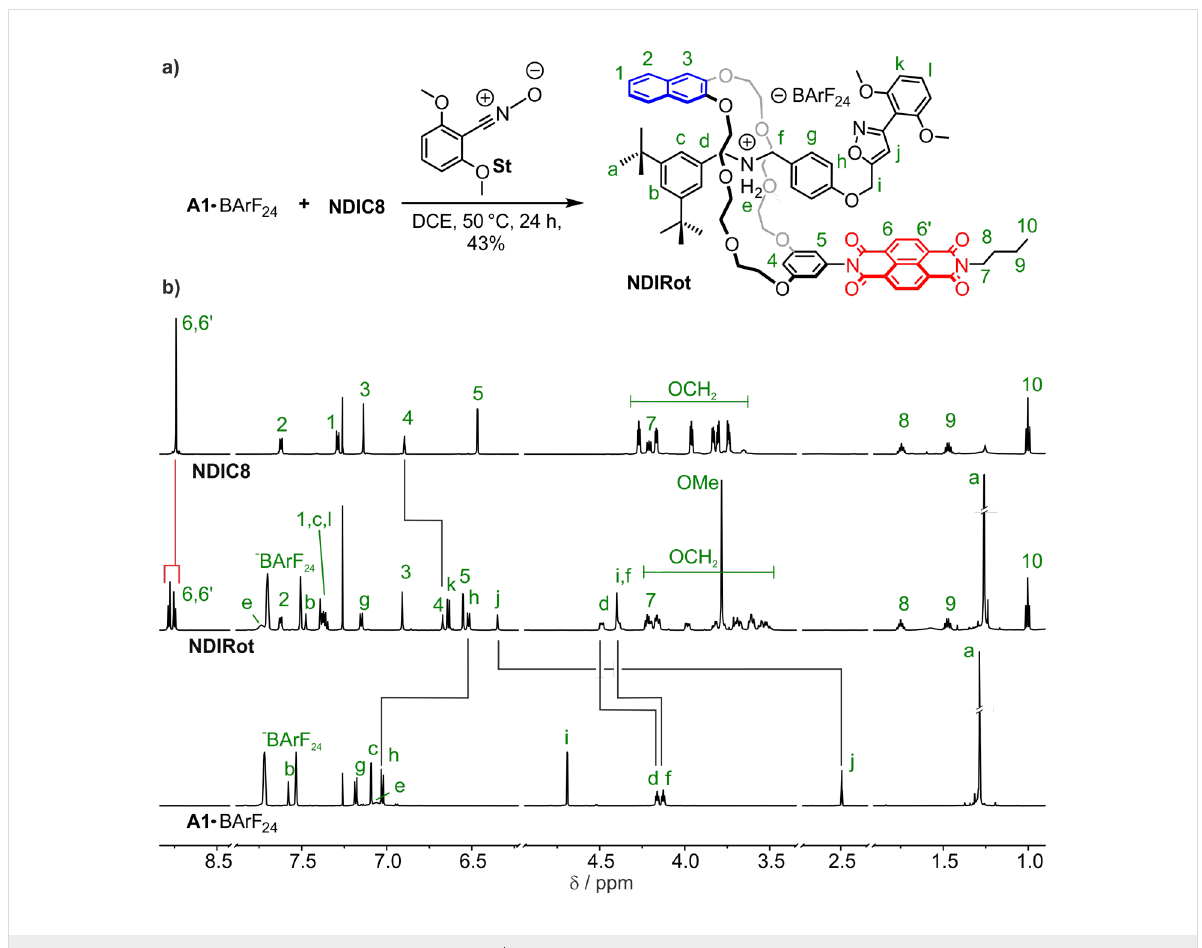
Figure 3: a) Synthesis of the [2]rotaxane NDIRot . b) Stacked 1 H NMR spectra (700 MHz, CDCl 3 , 298 K) of NDIC8 (top), NDIRot (middle), and A1· BArF 24 (bottom). The signal assignment was done by 2D NMR